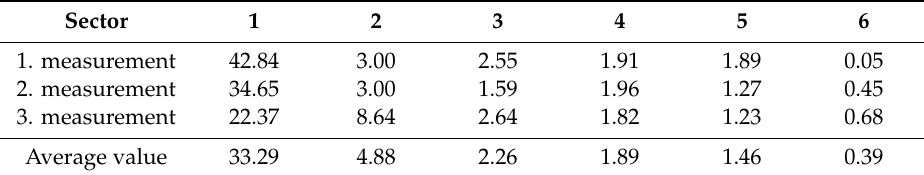
Table 3. Third set of measurements of oil film areal density (g / m 2 )—a slim tube with the inner diameter of 35 mm.